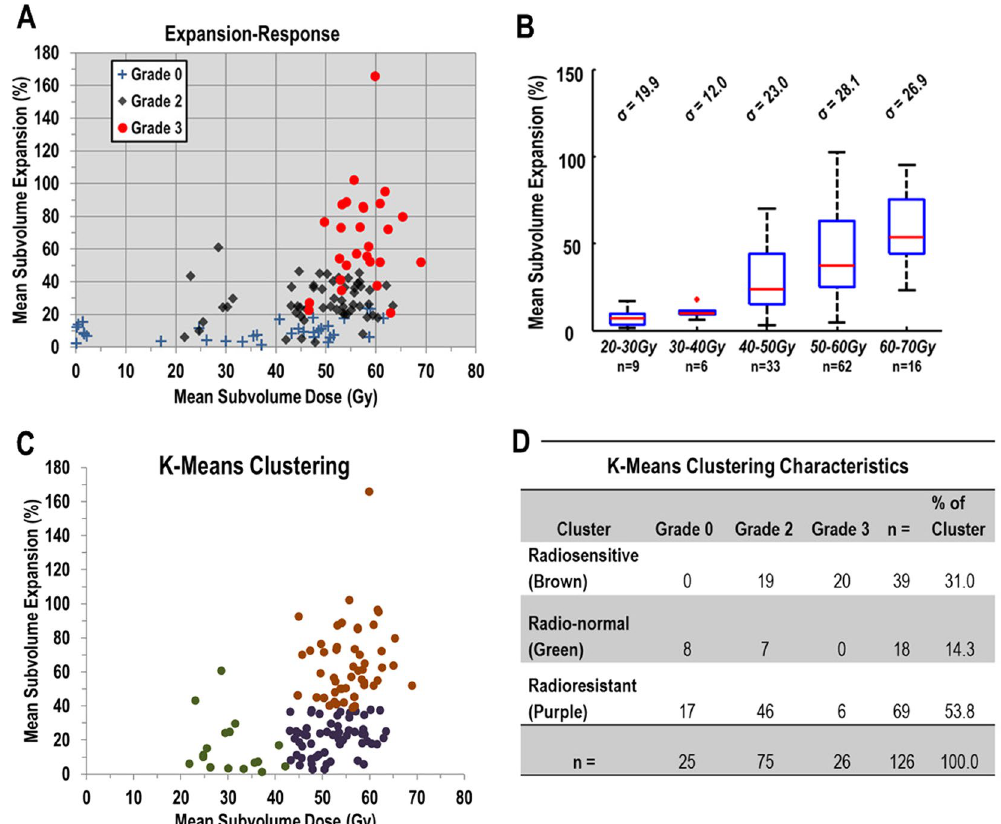
Figure 3. ( A ) Plot of expansion-response at the end of radiation therapy (approximately fraction 30) in the analyzed subvolume of the esophagus for 134 study patients. Patient markers denote maximum esophagitis grade during treatment. ( B ) Boxplot of the distribution of mean subvolume esophageal expansion, grouped according to mean subvolume doses of 20 to 30 Gy, 30 to 40 Gy, 50 to 60 Gy, and 60 to 70 Gy, for 126 study patients with the expansion-response quantified around treatment fraction 30. The standard deviation of expansion in each dose group is shown above each box. The edges of the box represent the quartile values of expansion, with the red line within each box representing that groups median expansion value. The range of values is represented by the black whiskers and the red ‘ + ’ denotes outliers (values beyond 1.5 times the interquartile range from the edge of the box). ( C ) Patient membership in radiosensitivity clusters after application of K-Means clustering on the expansion-response of the patient population. ( D ) Table of the characteristics of clustering membership for K-Means clustering for expansion-response at the end of radiation therapy for the 126 patients analyzed in the cluster